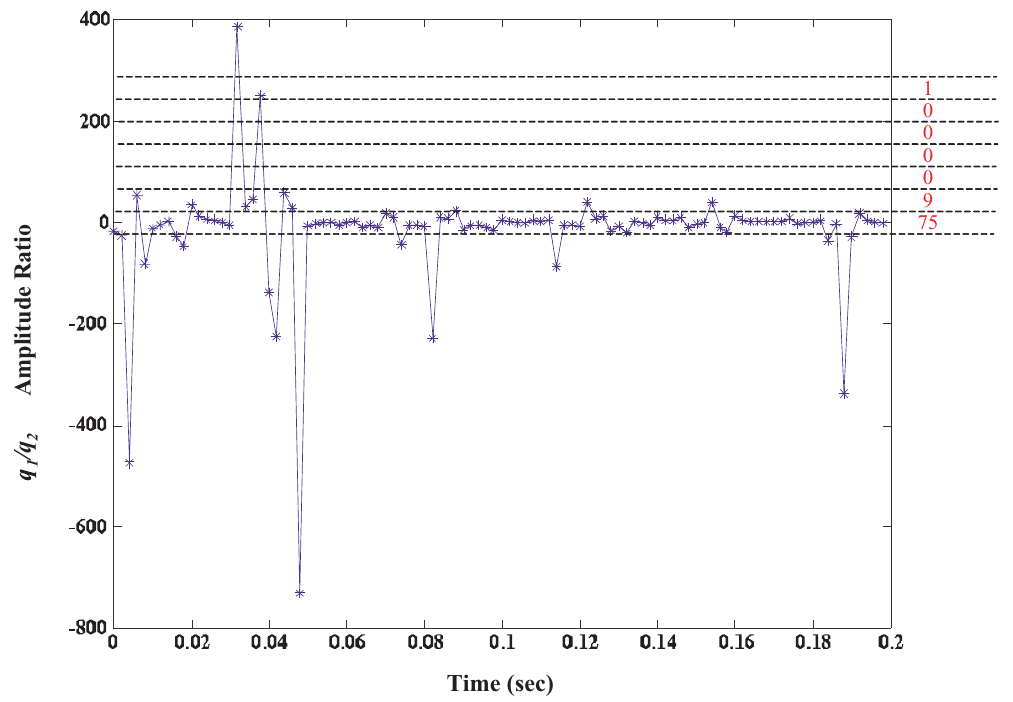
Fig. 5. Typical ratio of q 1 /q 2 while vehicle is in motion-an example of data discretization by banding.